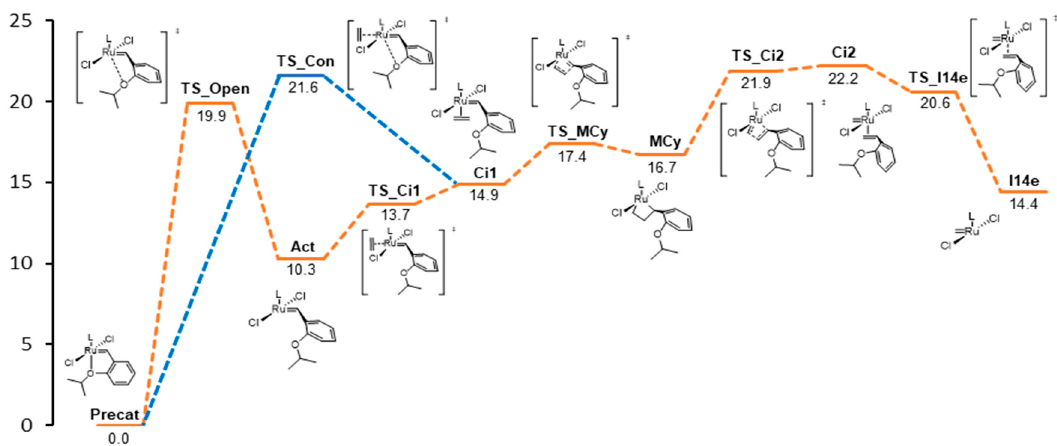
Figure 2. Calculated reaction profile for the initiation of the neutral HOV catalyst (free energies in kcal / mol). Blue lines correspond the concerted bonding of ethylene together with the Ru–O bond cleavage (free energies in solvent given in kcal/mol).